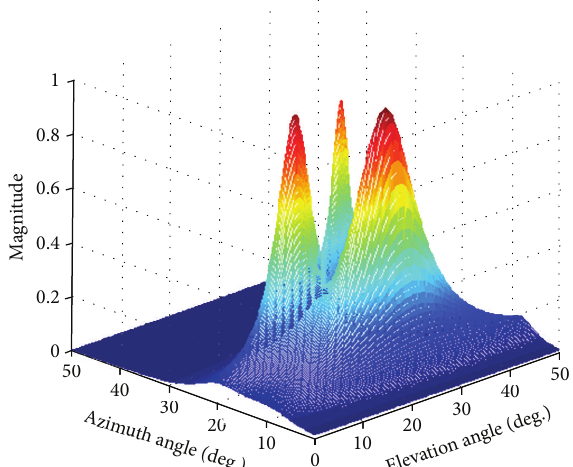
Figure 10: The spectrum search result of the proposed algorithm for the